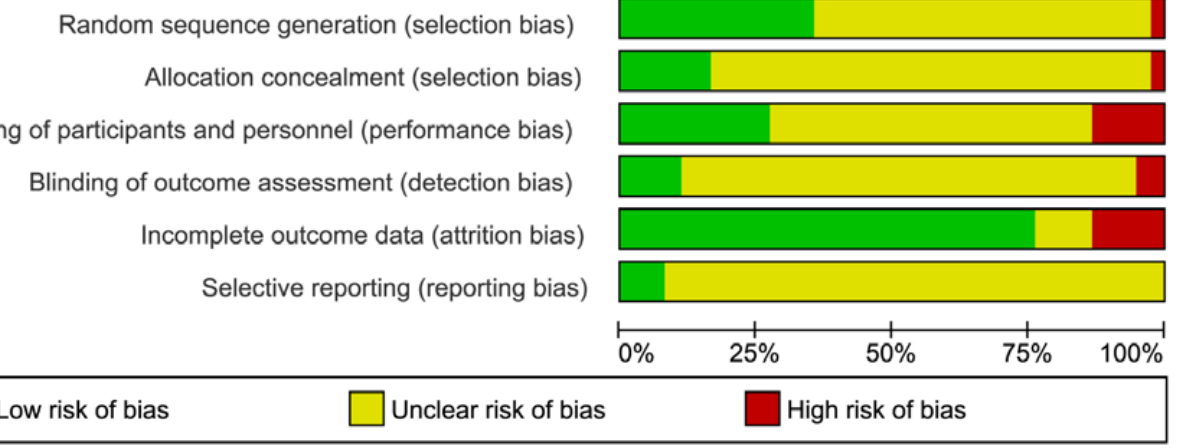
Figure 2A. Risk of bias assessment tool. Across trials, information is either from trials at low risk of bias (green), or from trials at unclear risk of bias (yellow), or from trials at high risk of bias (red).